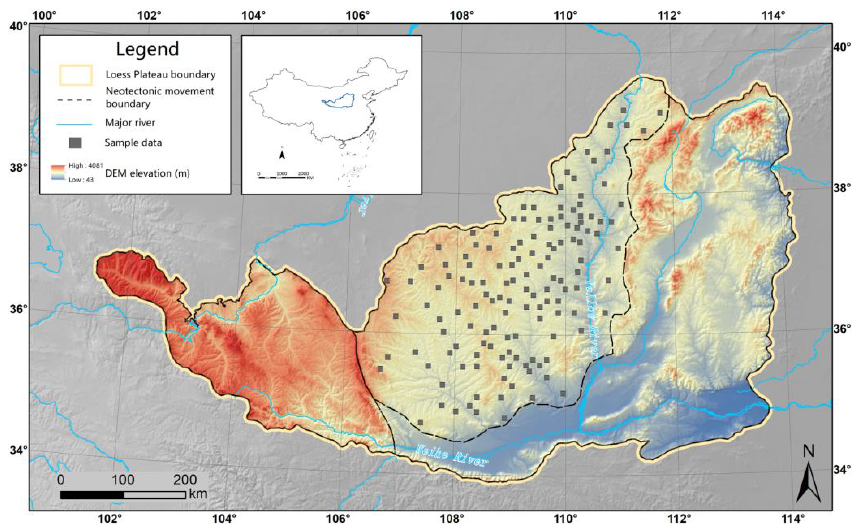
Figure 2. Study area and sample data.